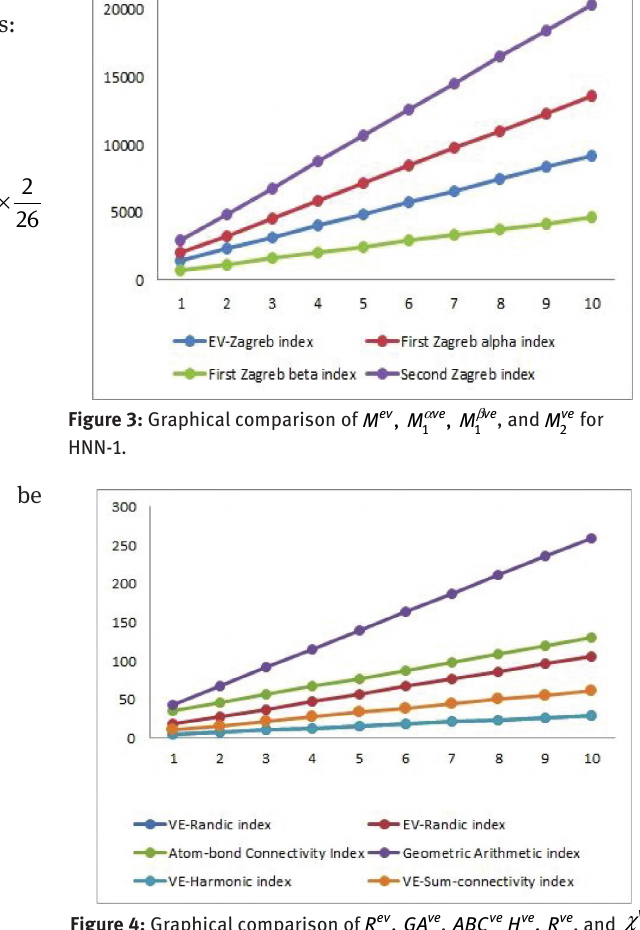
Figure 4: Graphical comparison